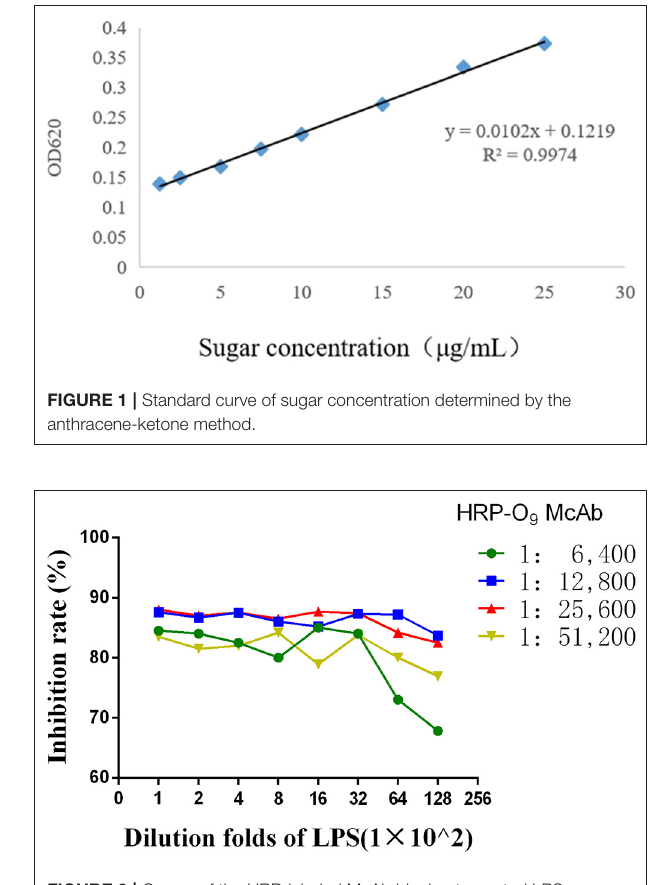
FIGURE 2 | Curves of the HRP-labeled McAb binging to coated LPS.